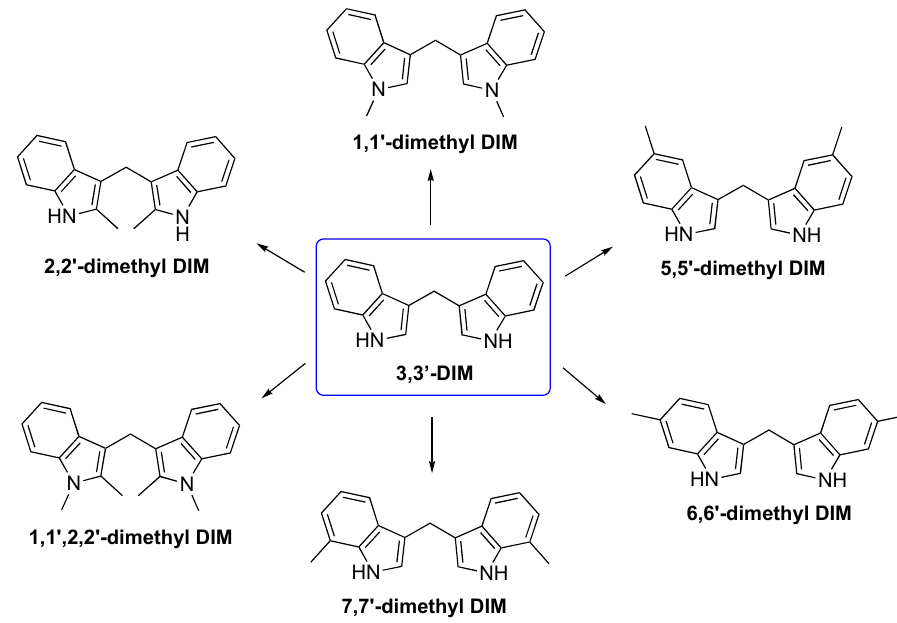
Figure 5. 3,3 ′ -DIM derivatives variously substituted. Figure 5. 3,3 (cid:48) -DIM derivatives variously